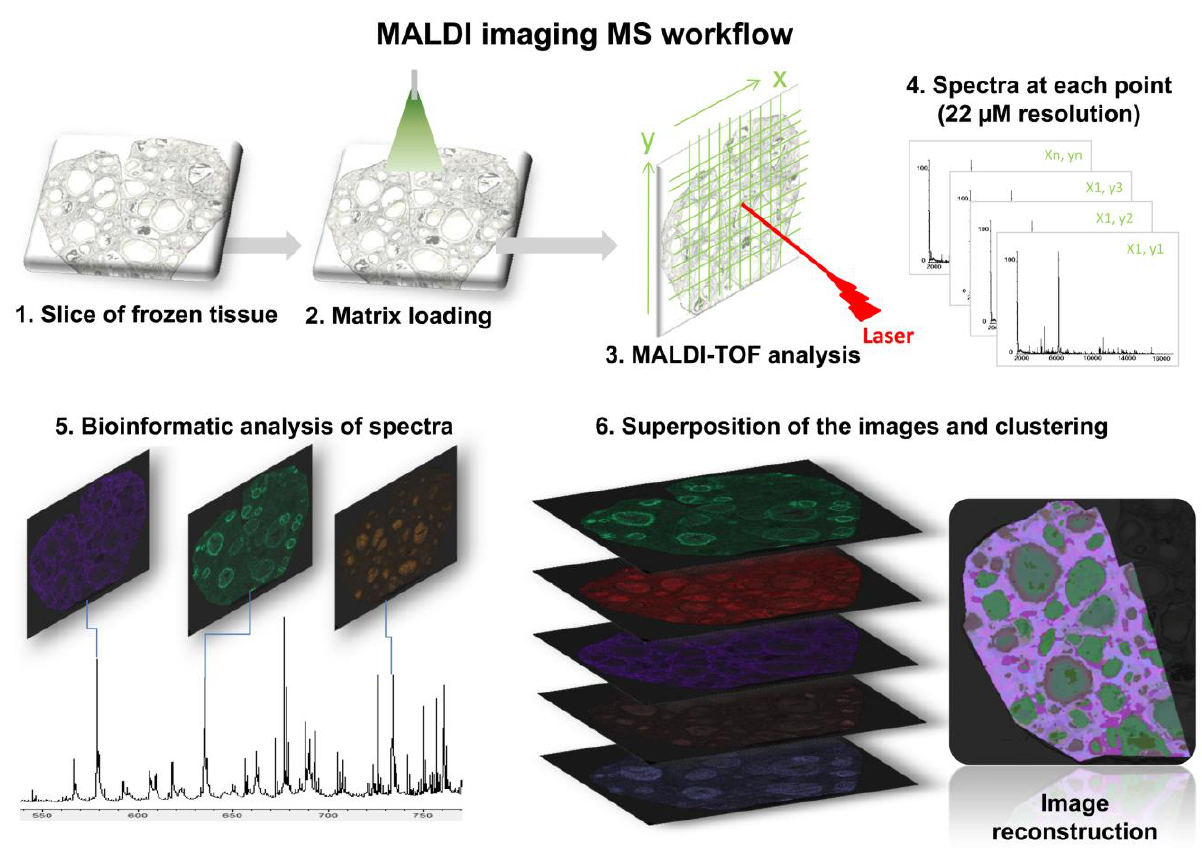
Figure 1. Schematic representation of MALDI Mass Spectrometry Imaging (MSI) of lipids performed on fresh frozen sections of Sus scrofa gilt ovaries. Cryostat ovary section